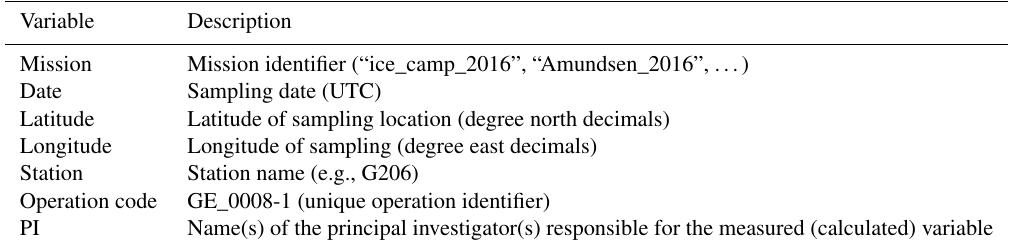
Table 4. Name and description of variables systematically included in datasets (i.e., in each .csv